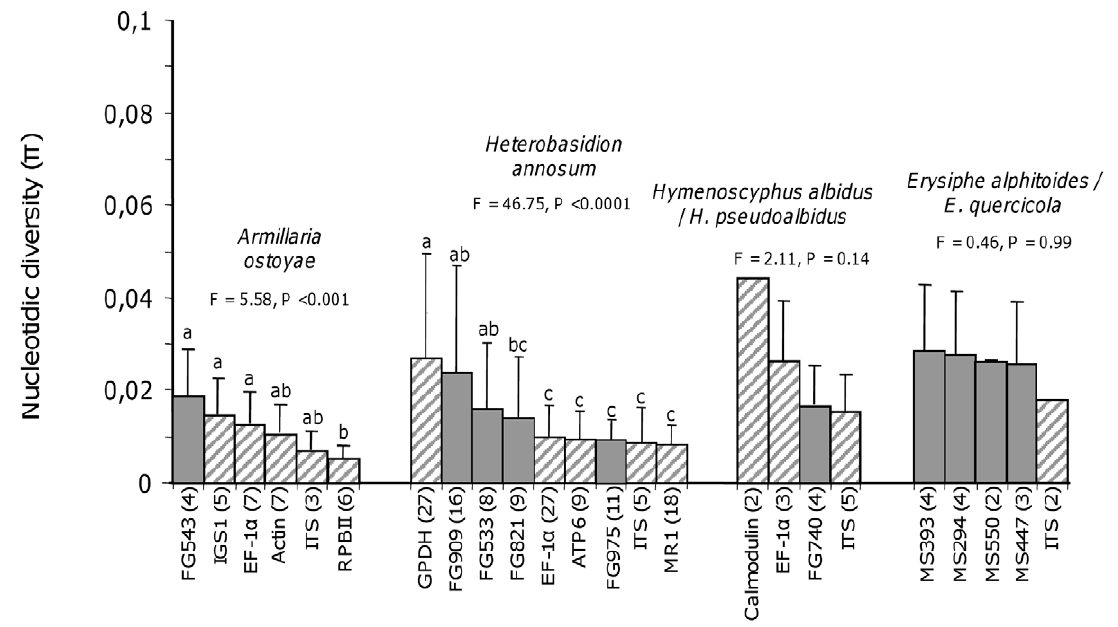
Figure 3. Nucleotidic diversity levels obtained for the PHYLORPH genes. The nucleotidic diversity levels obtained for the PHYLORPH genes (identified on the abscissa with their FUNYBASE ID) in the four non-model system considered are compared with those obtained for loci commonly used in multigene phylogenies for the same systems (retrieved from the NCBI database: Actin, c -actin gene; ATP6, mitochondrial ATP synthase subunit 6 gene; Cal, Calmodulin gene; EF-1 a , Elongation Factor- a 1 gene; GPDH, Glyceraldehyde-3-phosphate dehydrogenase; IGS, Intergenic spacers I of the nuclear rDNA; ITS, internal transcribed spacer of the nuclear rDNA; MR1, MRI, portion of two non-homologous mitochondrial rDNA insertions in the ML5–ML6 region; RPBII, largets subunit of the RNA polymerase II gene). In plain grey, PHYLORPH genes; In dashed grey, loci commonly used in multigene phylogenies. Letters above columns indicate significant differences between nucleotidic diversity means as determined by a Tukey’s HSD test after significant one-way ANOVA.